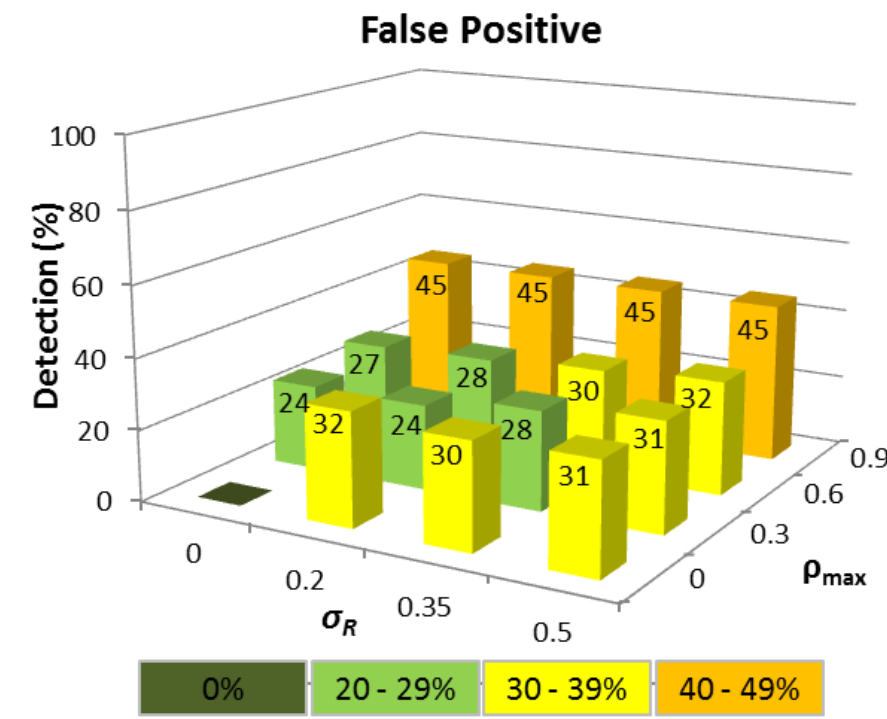
Figure 6. False positive detection for different wormhole HC under variable network traffic loads ( ρ ) and routing packet service times ( σ max